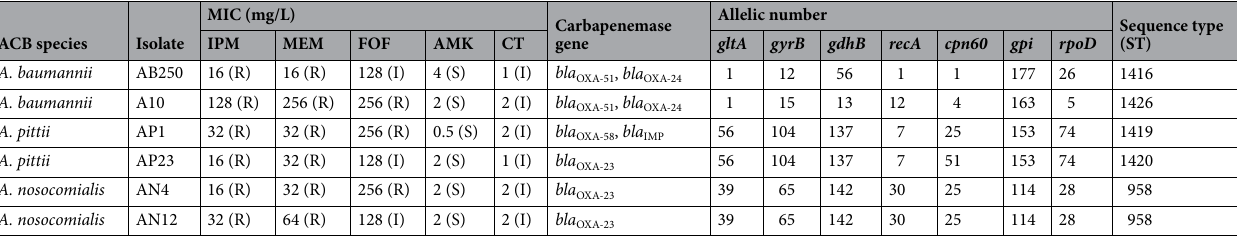
Table 1. The minimum inhibitory concentrations (MICs) of six ACB isolates to imipenem (IPM), meropenem (MEM), fosfomycin (FOF), amikacin (AMK), and colistin (CT) were determined by agar dilution method. The results were interpreted as susceptible (S), intermediate resistant (I), or resistant (R). The presence of carbapenemase genes was performed by PCR. The clonality was performed by MLST Oxford scheme as seven allelic numbers and a sequence type